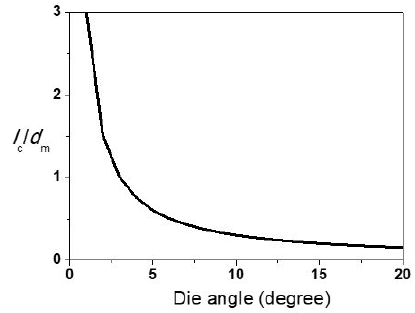
Figure 12. Variations in ( a ) SIF value, ( b ) maximum shear strain, ( c ) maximum effective stress, ( d ) maximum damage value, ( e ) temperature rise, and ( f ) drawing force of a wire with I DR .